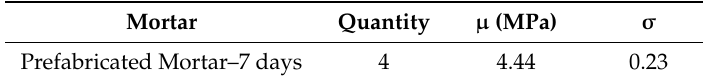
Table 5. Mortar compressive strength test results [39].